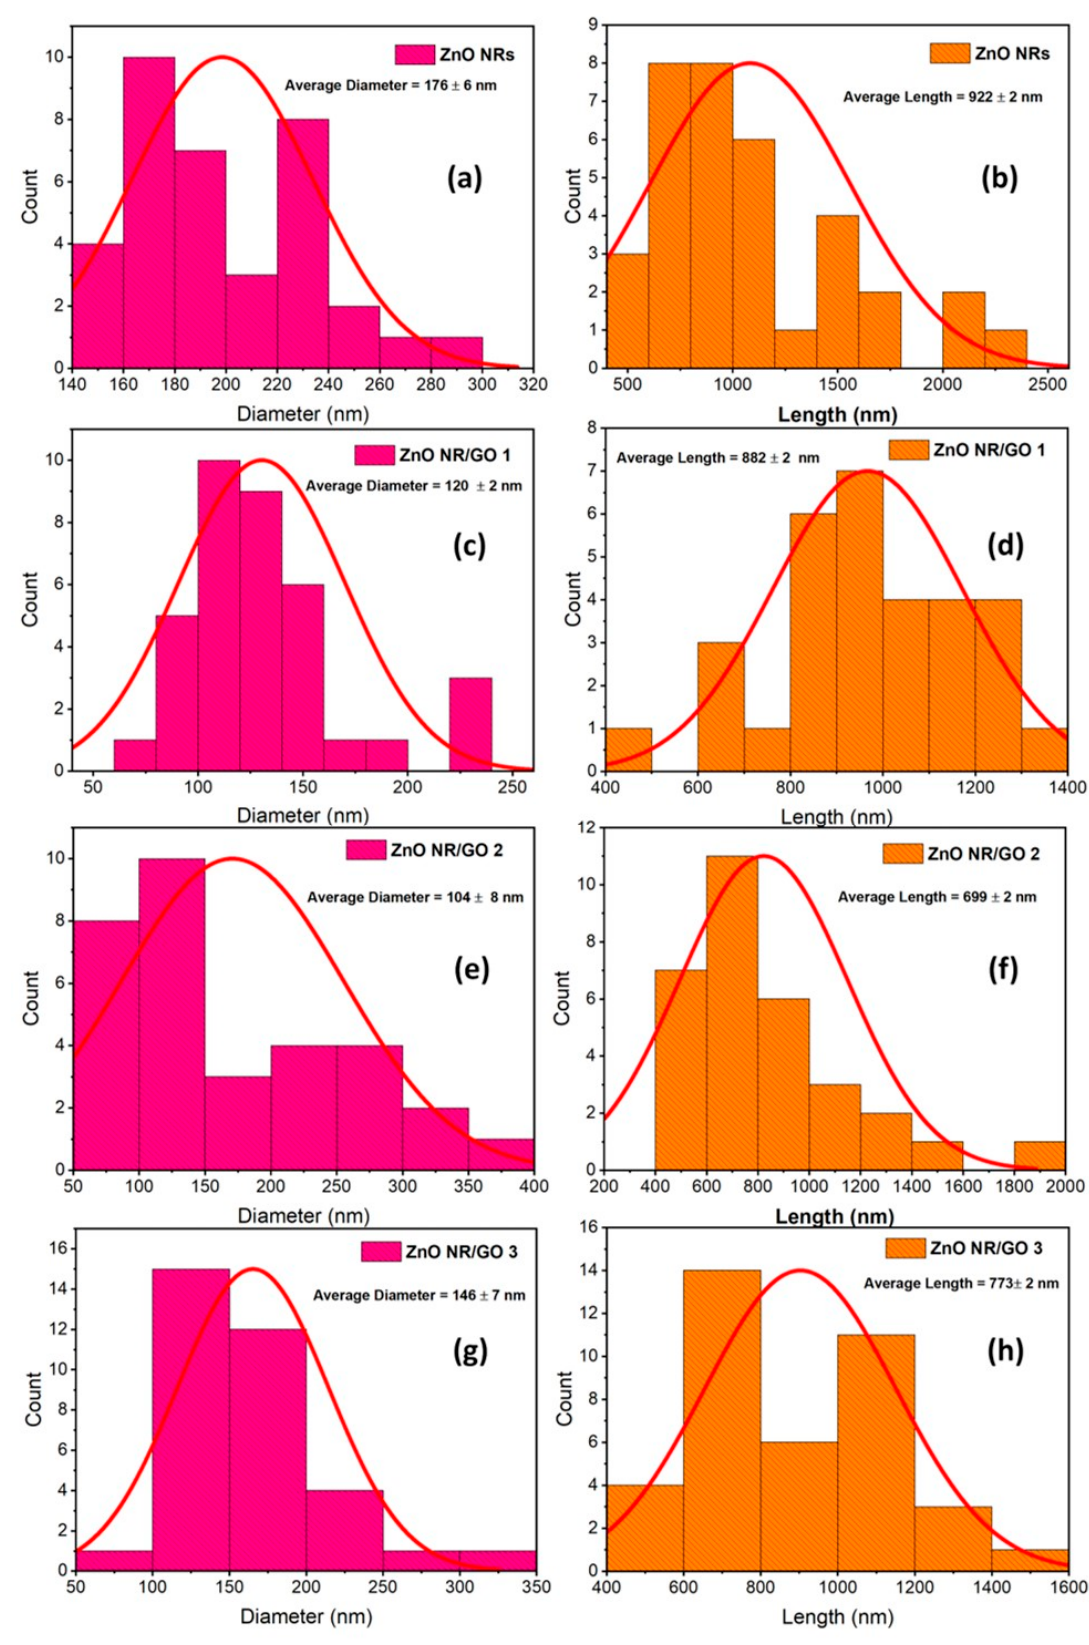
Figure 4. Diameter size distribution ( a , c , e , g ) and length size distribution ( b , d , f , h ) of ZnO NRs, ZnO NRs/GO1, ZnO NRs/GO2, and ZnO NRs/GO3 nanocomposites.